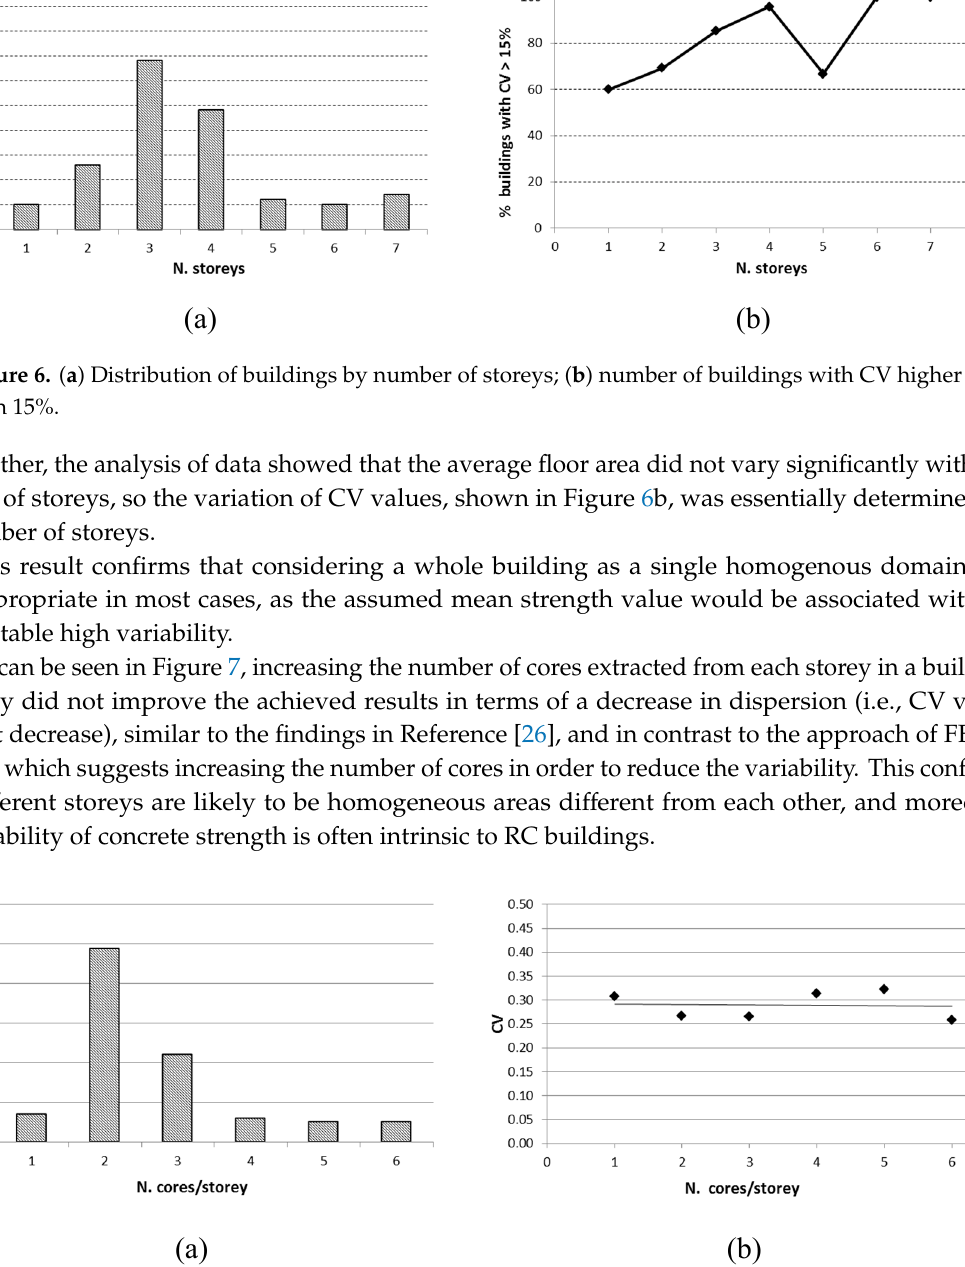
Figure 7. ( a ) Distribution of buildings as a function of the core number extracted from each storey; ( b ) CV values in relation to the mean number of cores extracted by single storeys.